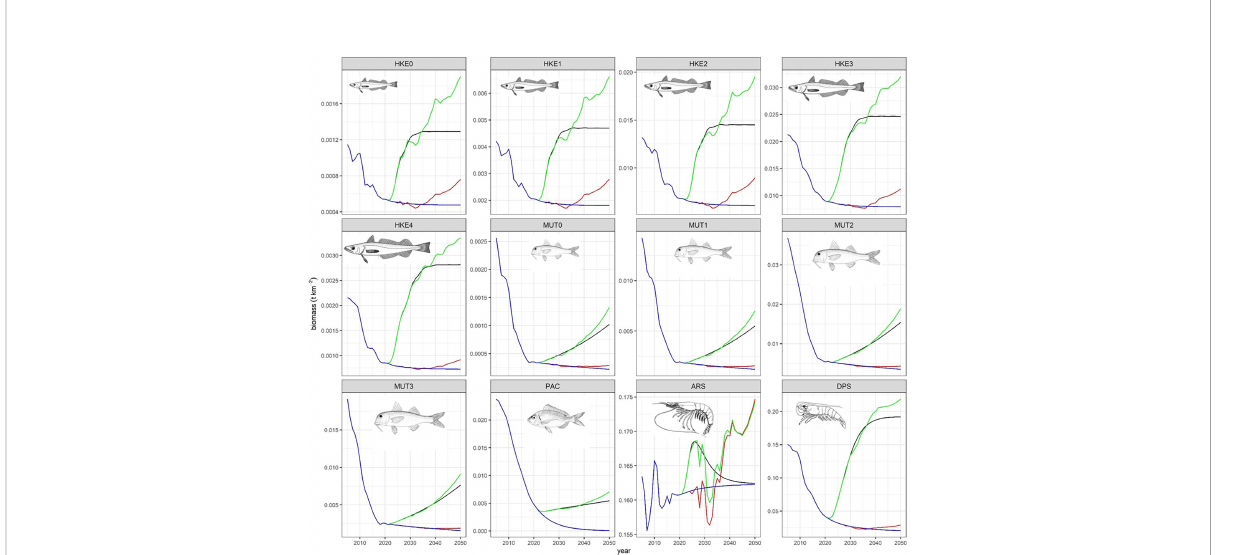
FIGURE 2 Trends of biomass along projection (2018-2050) and across scenarios, blue=REF, black= F, red= C, green= FC. The 12 groups comprise about 60% of bottom trawlers catches and 50% of total